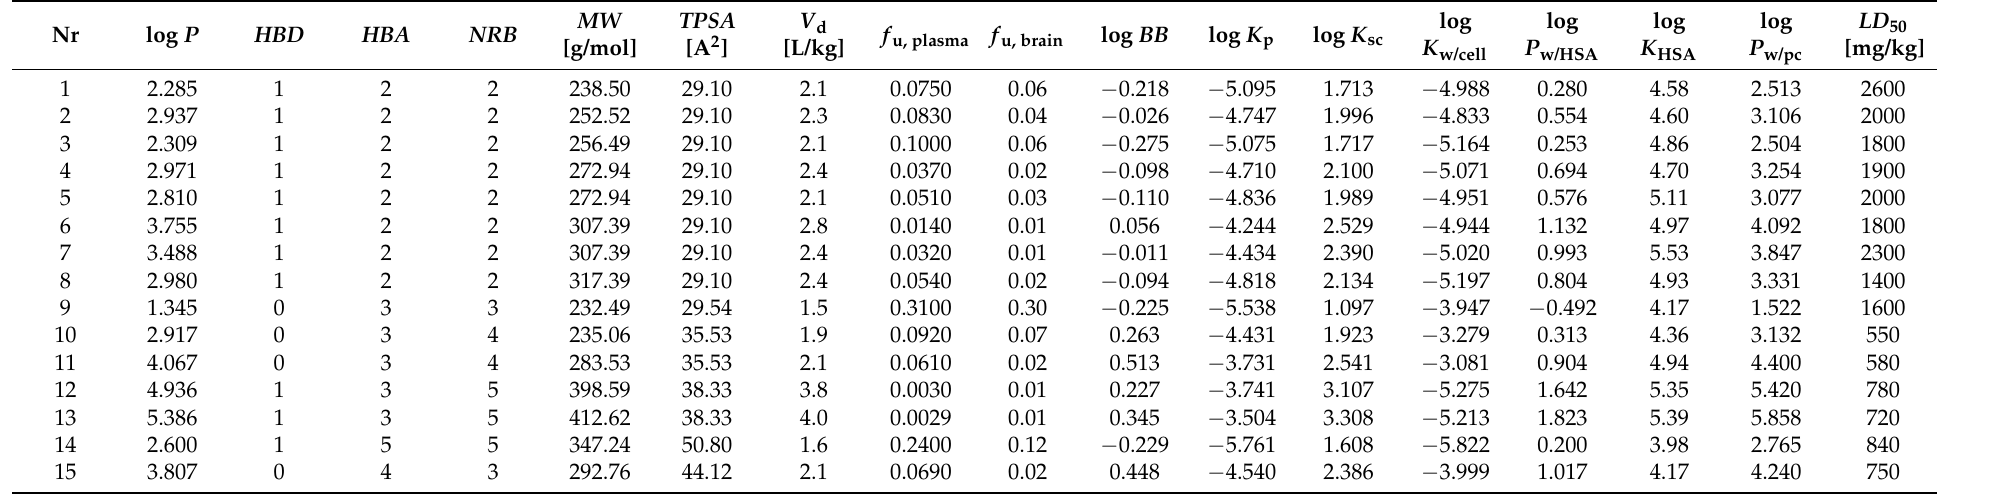
Table 2. Physicochemical, pharmacokinetic, and toxicity parameters of tested